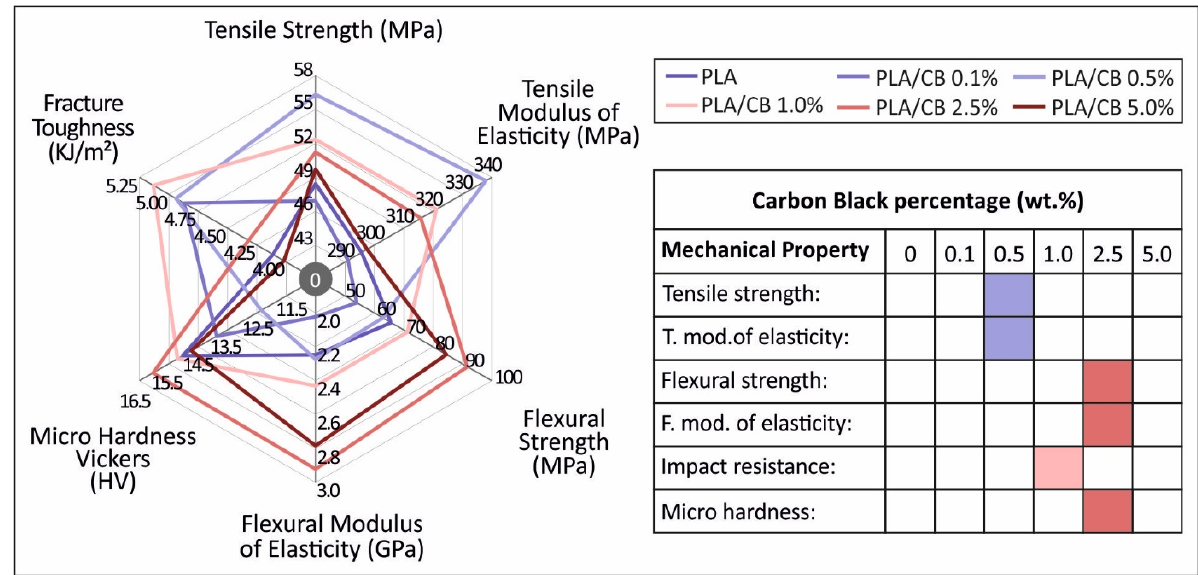
Figure 13. Overall results on the mechanical properties and performance of neat PLA compared to PLA/CB 3D printed nanocomposites.